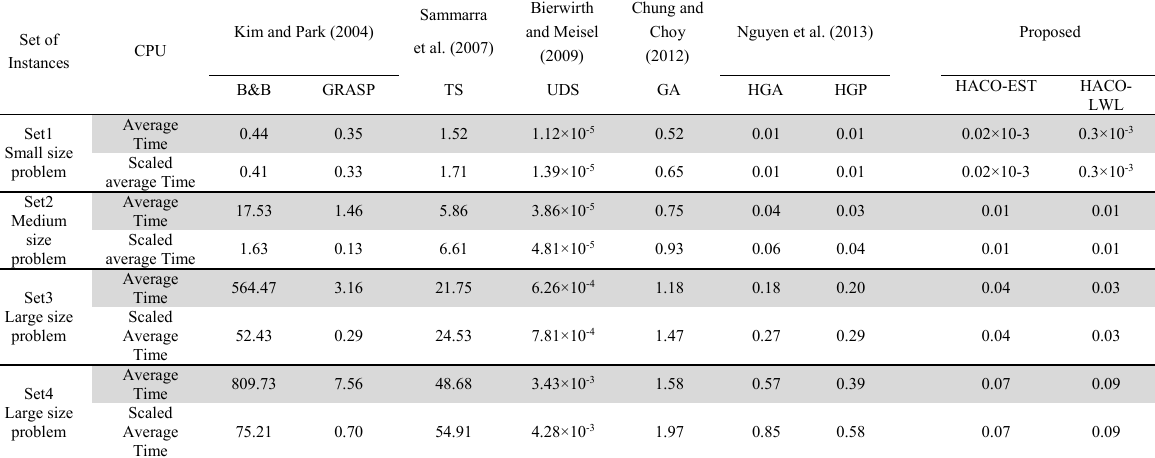
Computational times in minutes of B&B, GRASP, TS, UDS, GA, HGA, HGP, HACO-EST and HACO- LWL